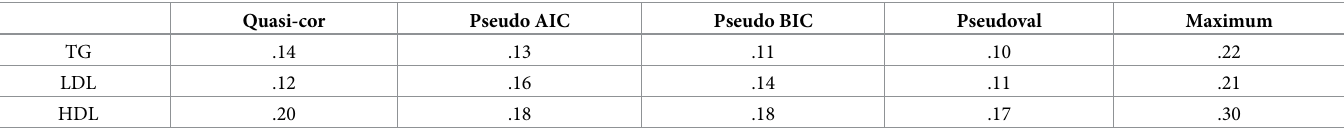
Table 2. Model performance, as measured by quasi-correlation of the model predicted into the BioBank data, for each model selection method. Models were esti- mated via TlpSum on the Teslovich data.